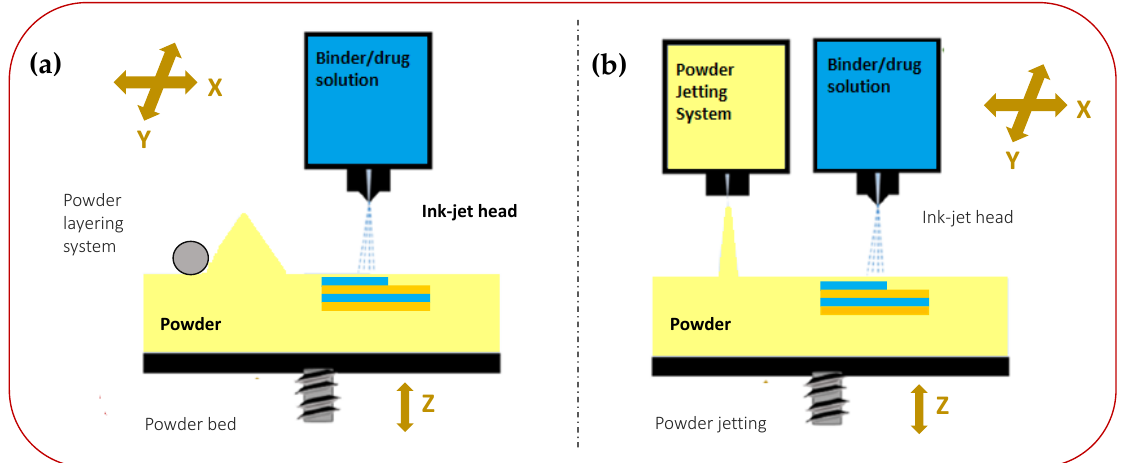
Figure 9. Illustration of a DOS deposition process with ( a ) powder bed layering system and ( b ) powder bed jetting system.